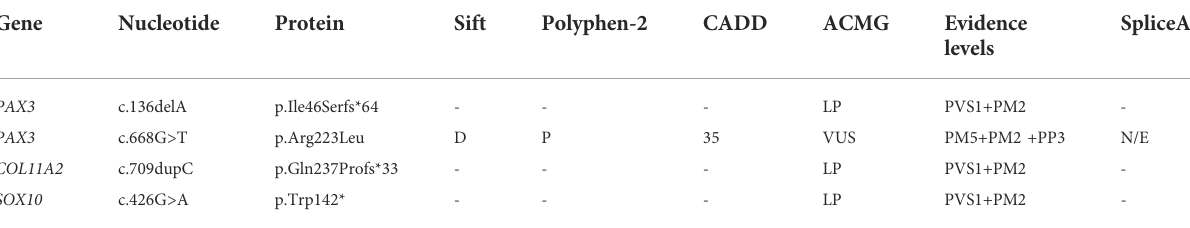
TABLE 1 Summary of Detected WS-related Novel Variants in this